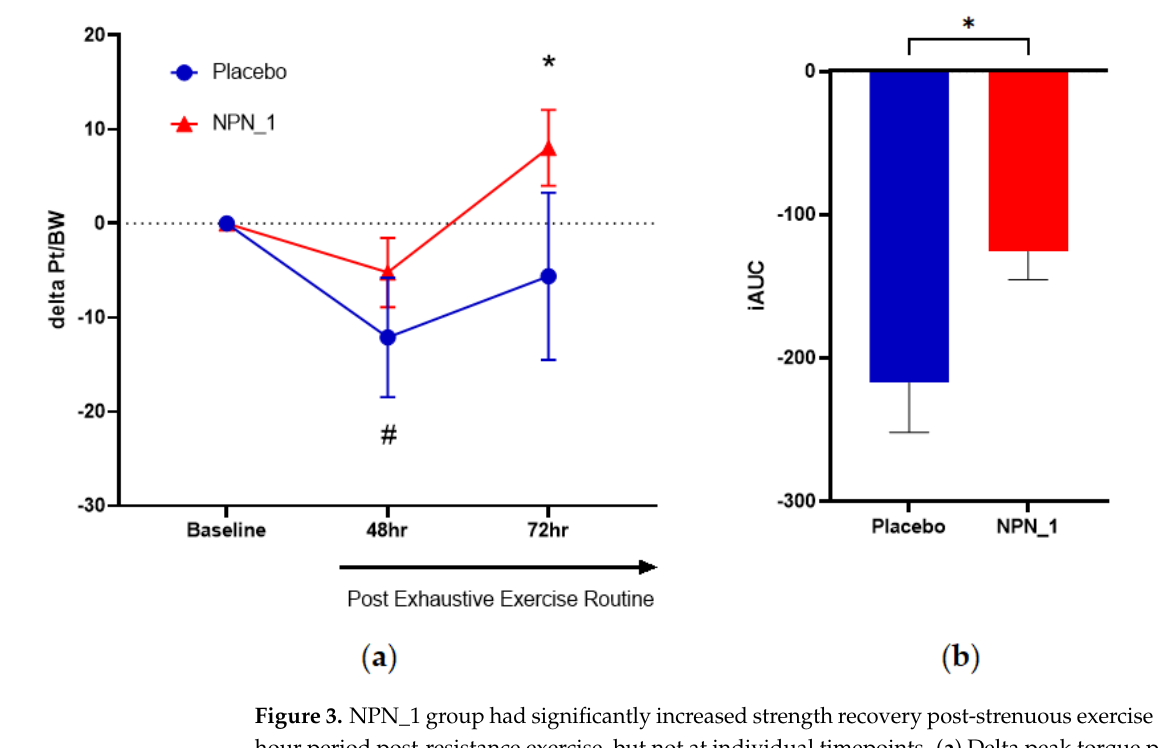
Figure 3. NPN_1 group had significantly increased strength recovery post-strenuous exercise over the hour period post-resistance exercise, but not at individual timepoints. ( a ) Delta peak torque per bodyweight was calculated per subject from their own baseline and expressed over time (mean ± SEM, RM-ANOVA, p = 0.226). * Indicates NPN-1 is significantly different from baseline strength ( t -test, p = 0.025). # Indicates Placebo is significantly different from baseline strength ( t -test, p = 0.032). ( b ) iAUC of strength recovery was calculated over the study duration (mean ± SEM, t -test, p = 0.020).